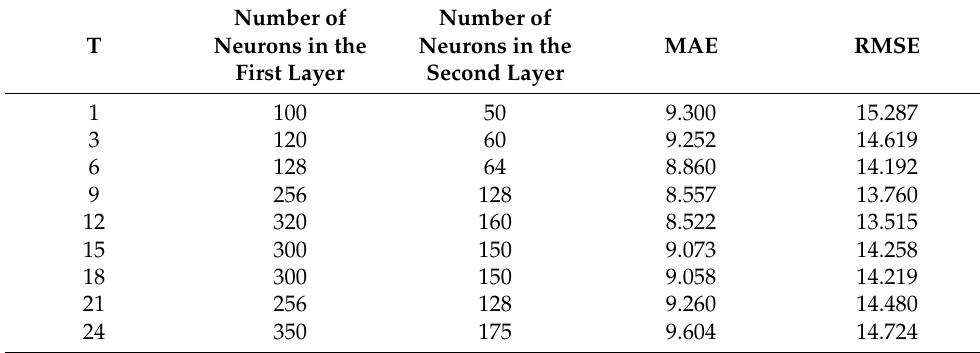
Table 3. The parameter setting and verification effect under different time windows.